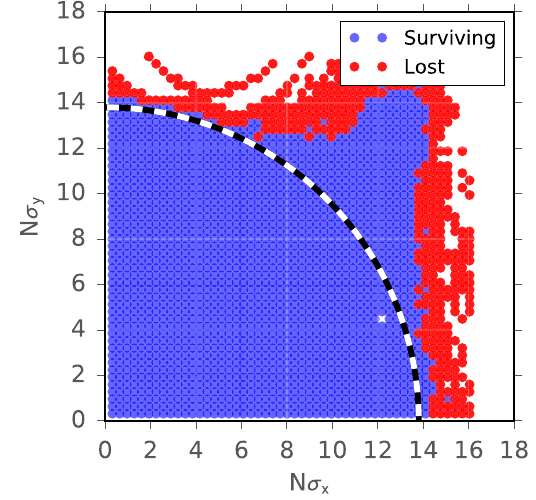
4. Simulated free dynamic aperture with excitations calculated from initialized amplitude. The machine tunes are Q 0 . 31 and Q 0 . 32 x ¼ x ¼